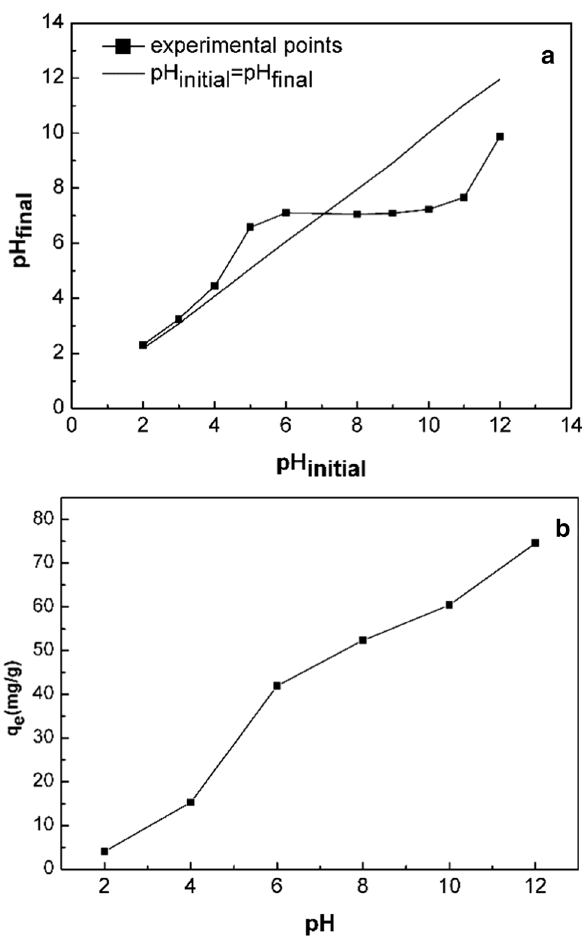
Fig. 5 a pHpzc of BNH-CM, b effects of solution pH of MB at initial concentration 100 mg/L onto BNH-CM at 40 °C and adsorbent dos- age 0.2 g